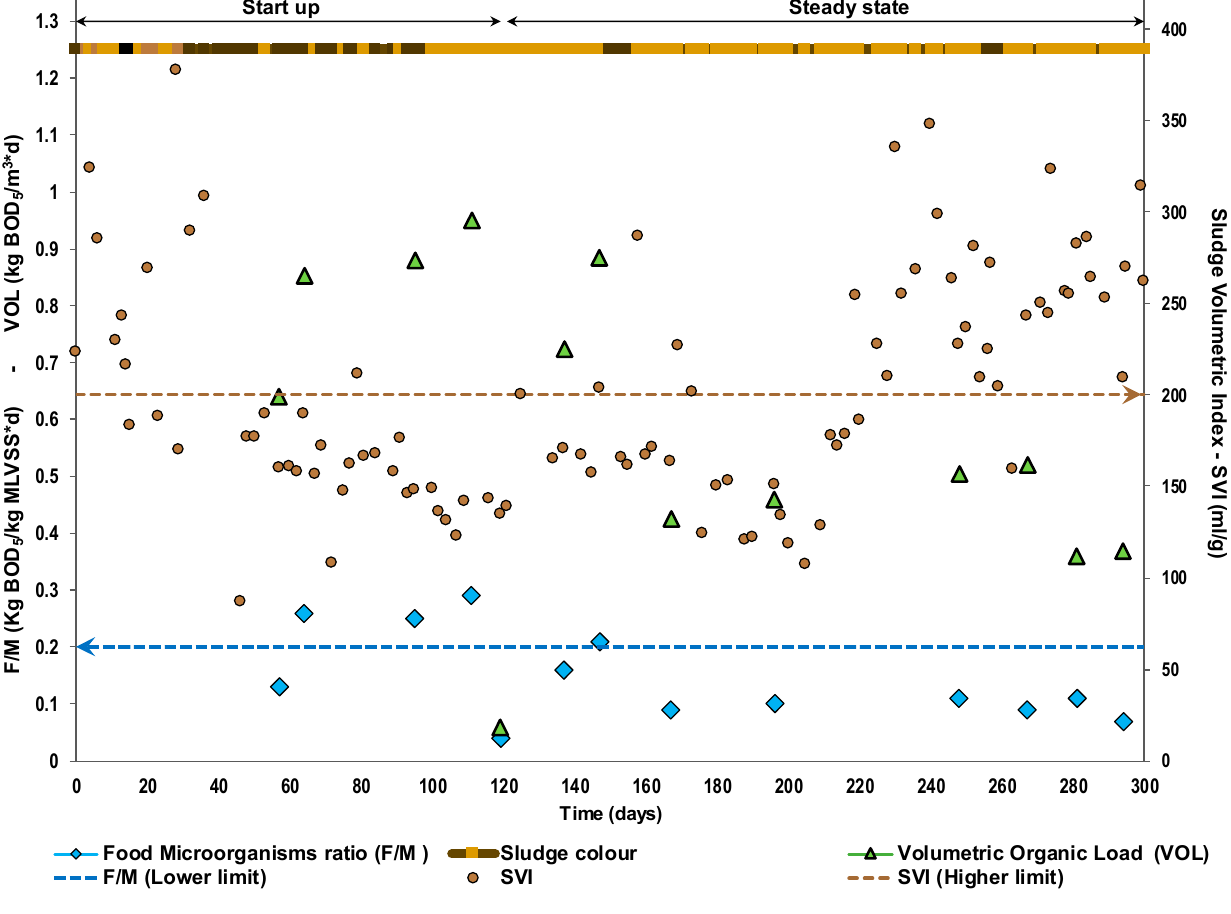
Figure 2. Variation in F/M, VOL, and sludge color in the aeration tank. During the start-up phase in the aeration tank, the predominant sludge colors were black and dark brown, indicating unstable operational conditions. This was related to the influence of the anaerobic effluent on the aeration tank sludge. This deficiency was man- aged by controlling the UASB effluent settleable solid concentration by increasing the by- pass or by increasing the aeration time.